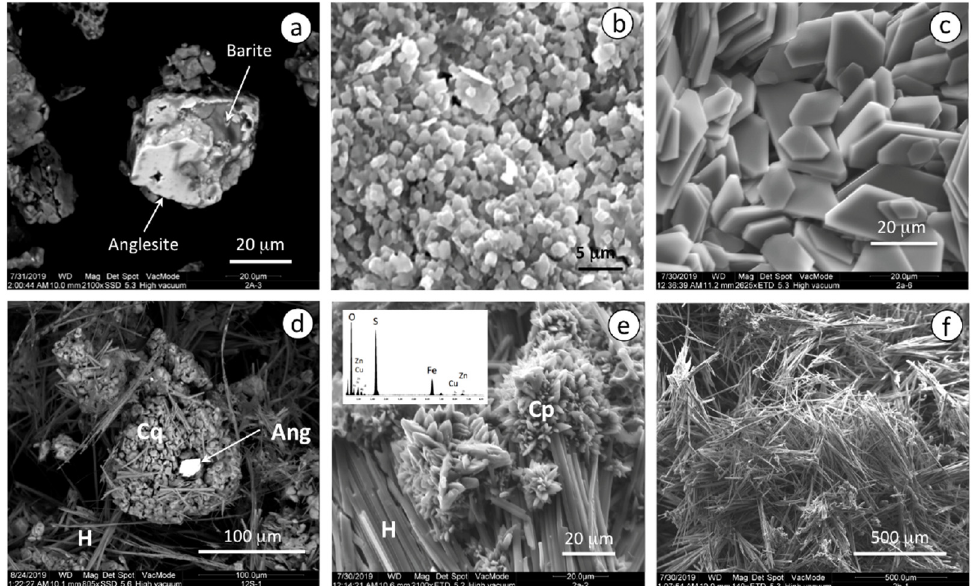
Figure 5. SEM images showing: ( a ) epitaxial overgrowth of anglesite on barite; ( b ) micron-sized crystals of jarosite; ( c ) tabular crystals of copiapite with pseudo-orthorhombic symmetry; ( d ) efflorescent mixture of coquimbite (Cq) and halotrichite (H) with anglesite (Ang); ( e ) inset EDS spectrum of copiapite (Cp) grown on fibrous aggregates of halotrichite (H); and ( f ) bundled, fibrous crystals of halotrichite. Table 2. Chemical composition of major and trace elements of the soil core samples collected along As expected, the sulphidic waste material is chemically characterized by elevated the north transect. concentrations of iron and sulphur (Tables 2 and 3). The maximum contents of Al 2 O 3 (14.48%) and K 2 O (2.01%) were measured in the deepest sample, where the mineralogical influence of the substrate becomes more apparent. The sulphide wastes have extremely high levels of PTEs (in mg kg − 1 ), particularly Pb (up to 34,754) and Zn (3665), as well as Cu (810) and some metalloids, As (828) and Sb (1563). The concentrations of Se (26.3), Tl (16.4) and Cd (10) found in some samples are also